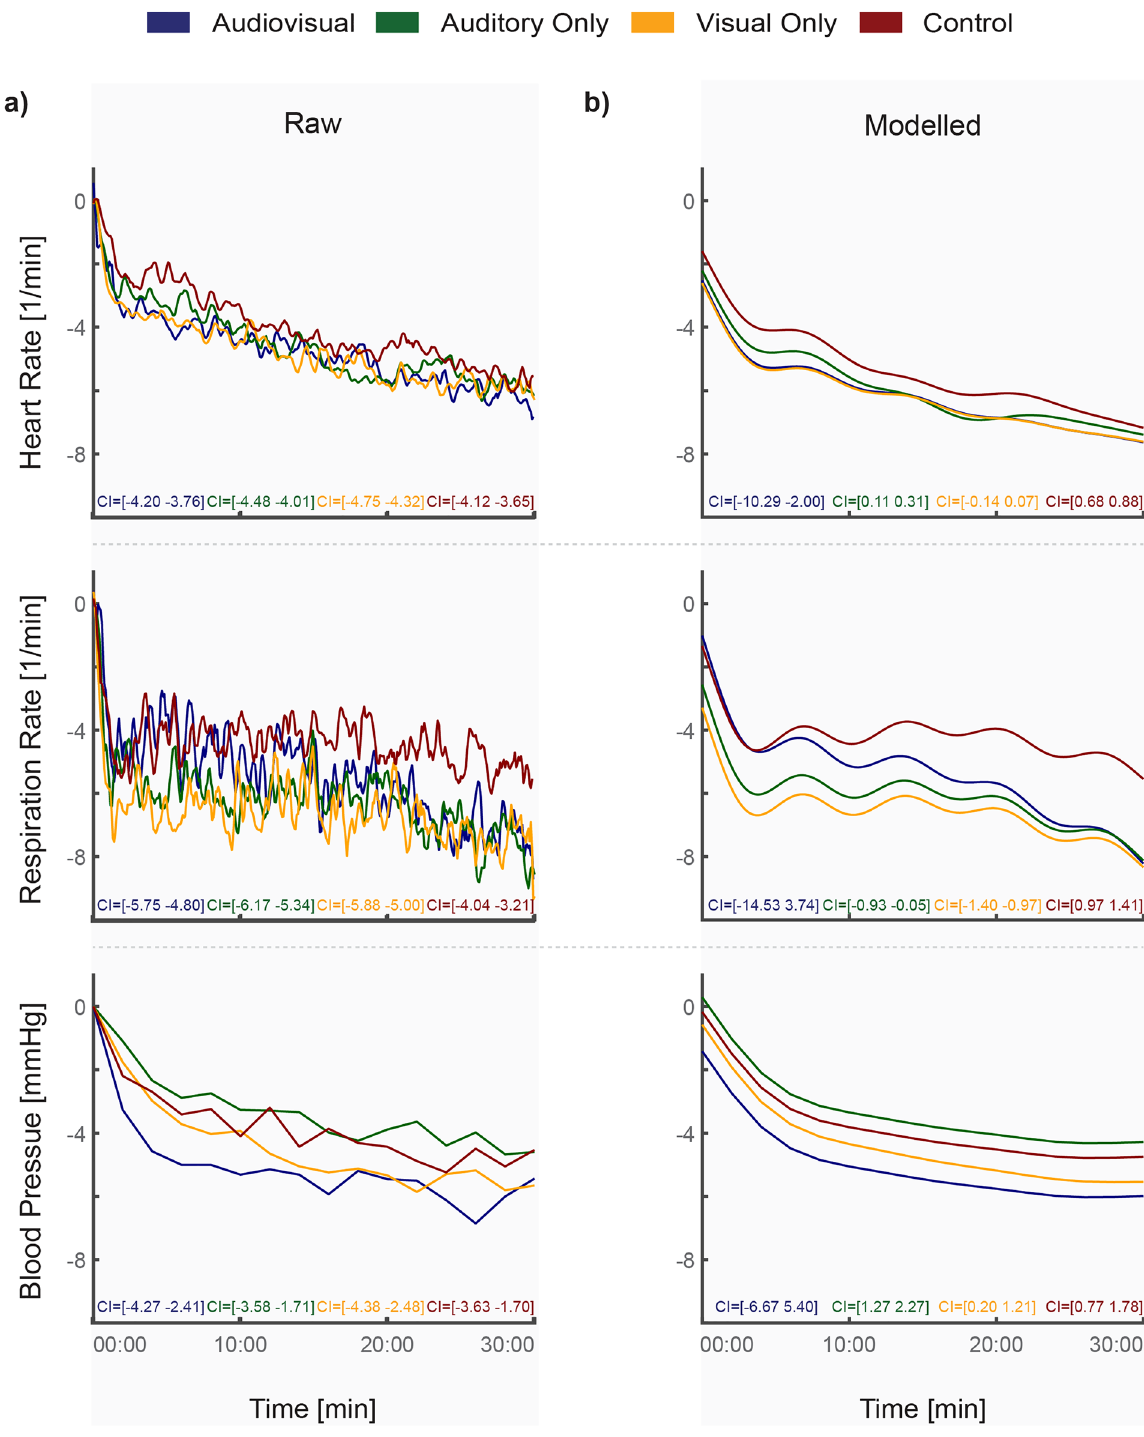
Figure 2. Physiological changes in heart rate (top), respiration rate (middle), and mean arterial pressure (bottom) over the 30-min intervention period. (Left) Raw data (n = 42) which has been centered to zero. 95% confidence intervals (CI) are shown at the bottom of each plot. (Right) Modelled data generated using the Generalized Additive Mixed Model and the raw data. 95% confidence intervals (CI) are shown at the bottom of each